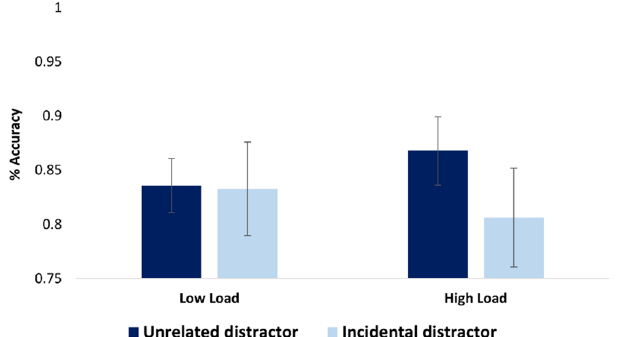
Figure 3. Results in Exp. 2. Main effect of recognition condition: p < .02. Load X recognition condition interaction: p < .03. Error bars indicate standard error of the